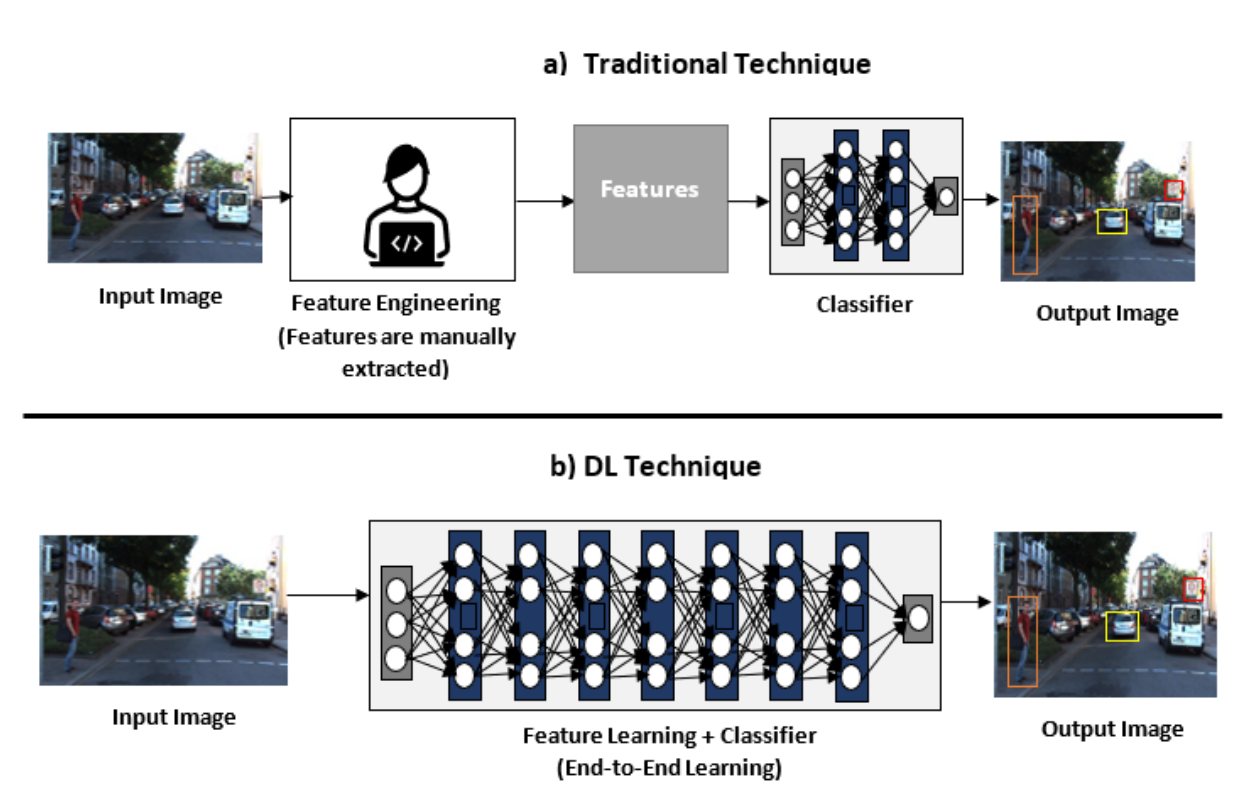
Figure 2. ( a ) Traditional techniques require engineers to manually extract features and then classifiers are used to learn the best descriptors. ( b ) In DL, the features are automatically extracted and learnt. (Modified version of